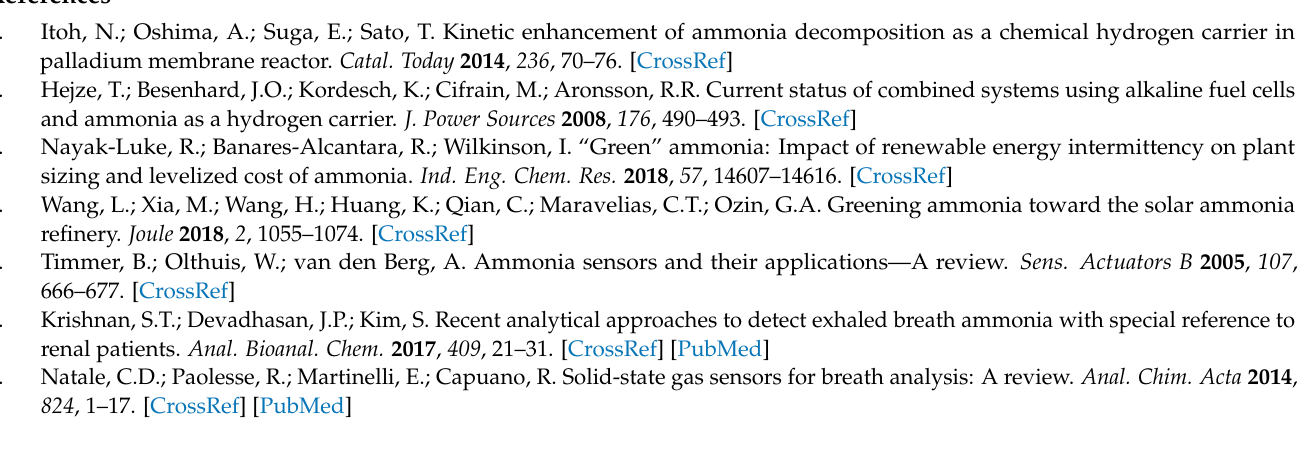
gold electrodes, Figure S2: Experimental setup used for NH 3 gas sensing measurement, Figure S3: Sensing mechanism of PANI-based NH 3 gas